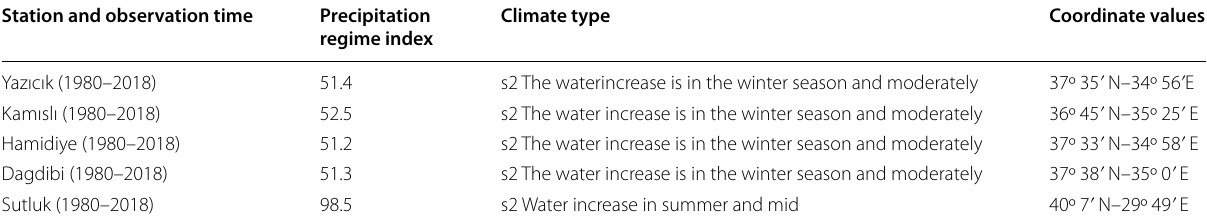
Table 5 Thornthwaite precipitation regime